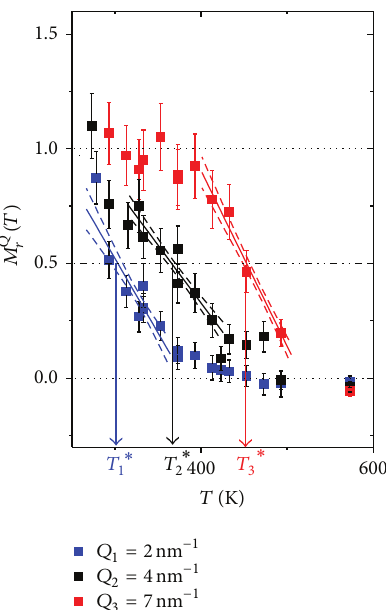
Figure 11: The longitudinal reduced modulus measured by IXS [14] as a function of 𝑇 and at the 𝑄 values indicated in the legend. For each curve, the center of the viscoelastic crossover, 𝑇 ∗ , is indicated by a vertical arrow as in Figure 9. The straight lines used for the interpolation of the viscoelastic crossover positions are reported (solid lines) together with the curve corresponding to 𝑎 ± 1𝜎 error (dashed